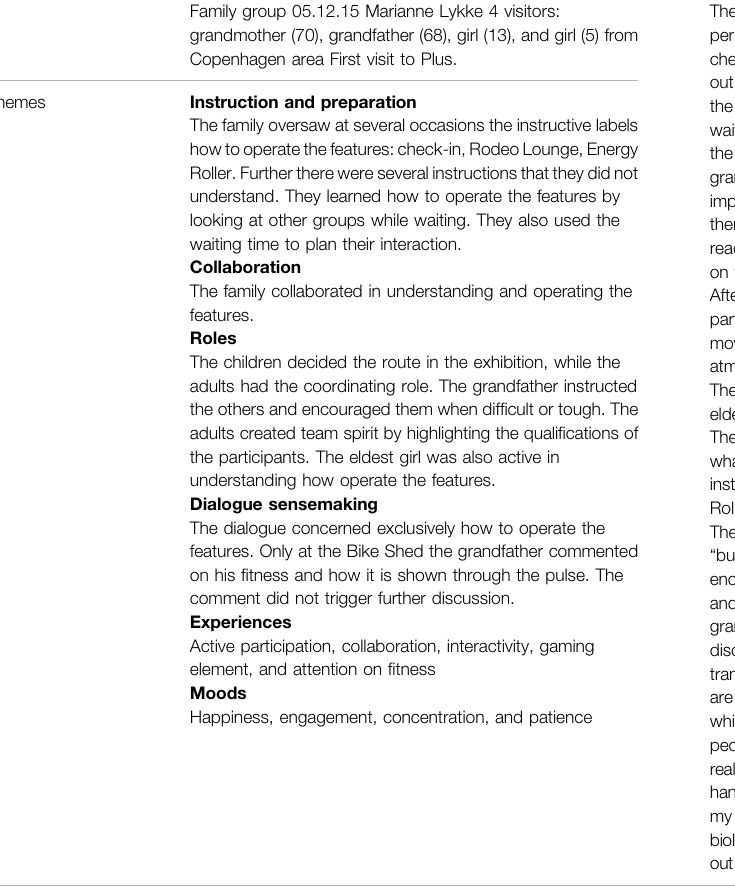
TABLE 3 | Experience map for walk-along